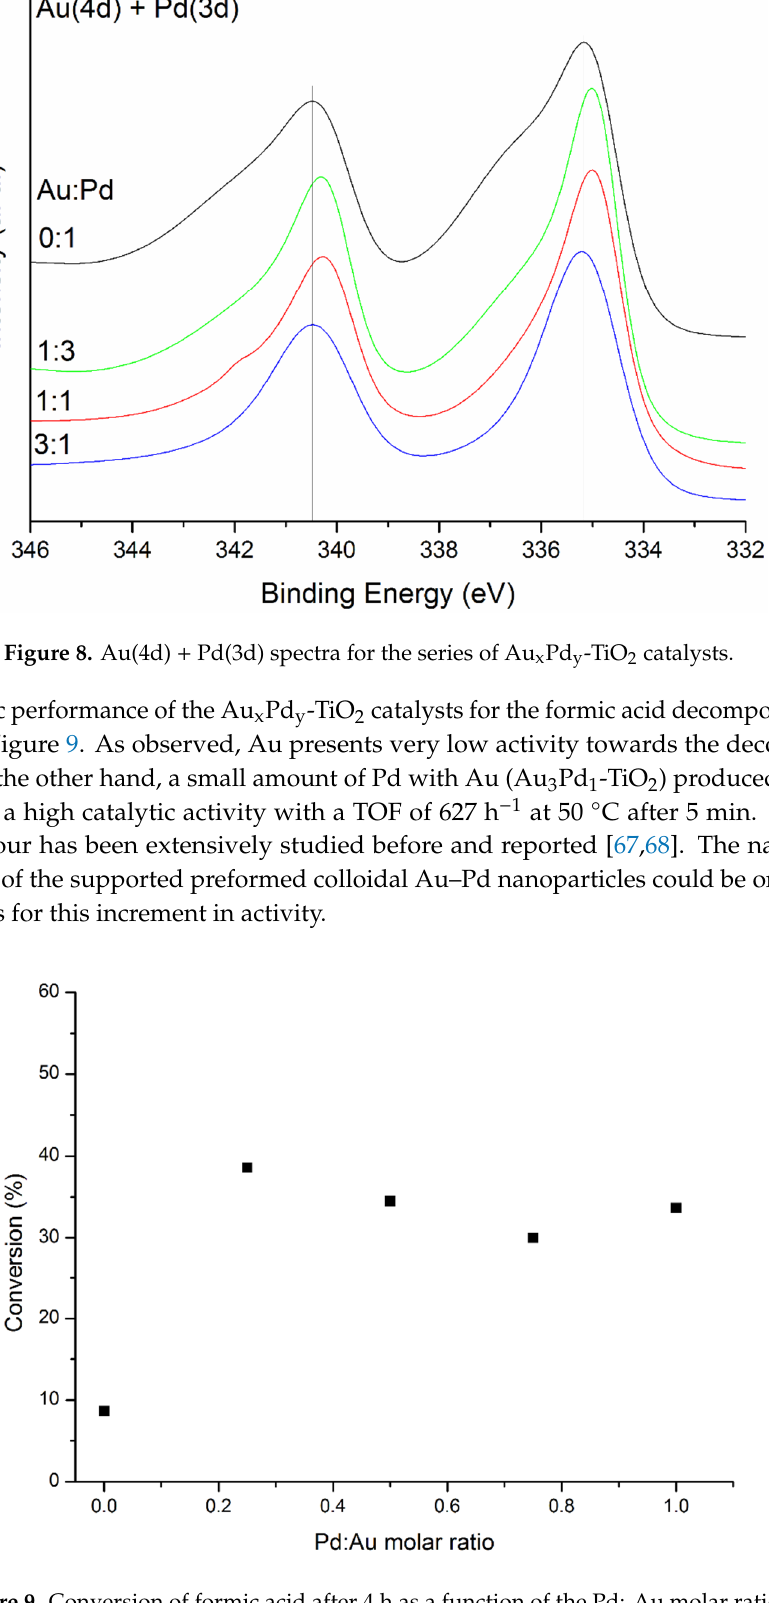
Figure 9. Conversion of formic acid after 4 h as a function of the Pd: Au molar